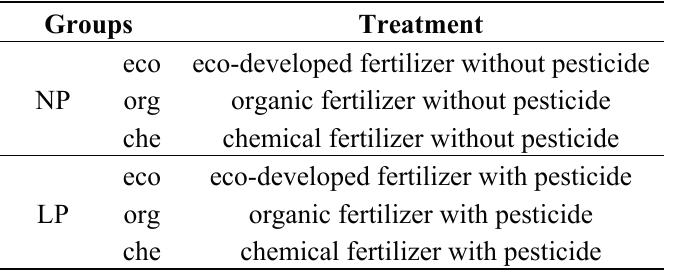
Table 6. Experimental field design.